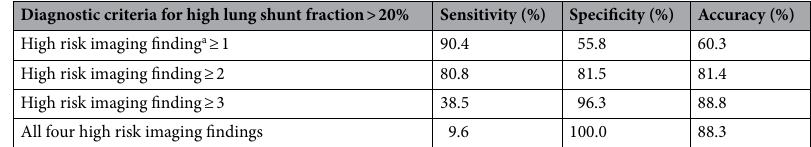
Table 3. Sensitivity and specificity of diagnostic criteria for predicting high lung shunt fraction higher than 20%. a Tumor size > 11 cm, hepatic vein invasion, early hepatic vein enhancement, and dysmorphic intratumoral vessel.